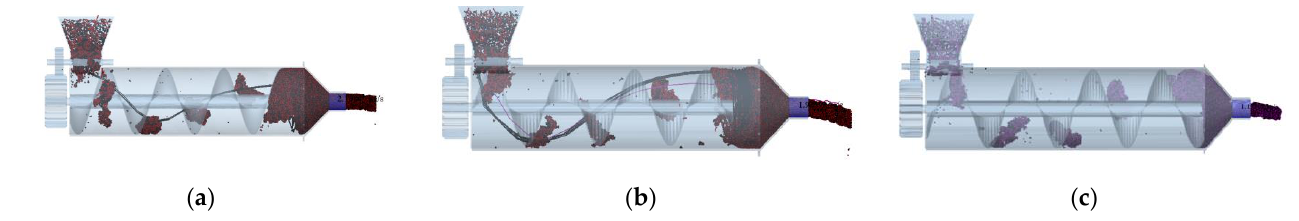
Figure 4. Simulation process for three different parameters of the underground irrigation pipe- forming device: ( a ) D 1 ; ( b ) D 2 ; ( c ) D 3 .